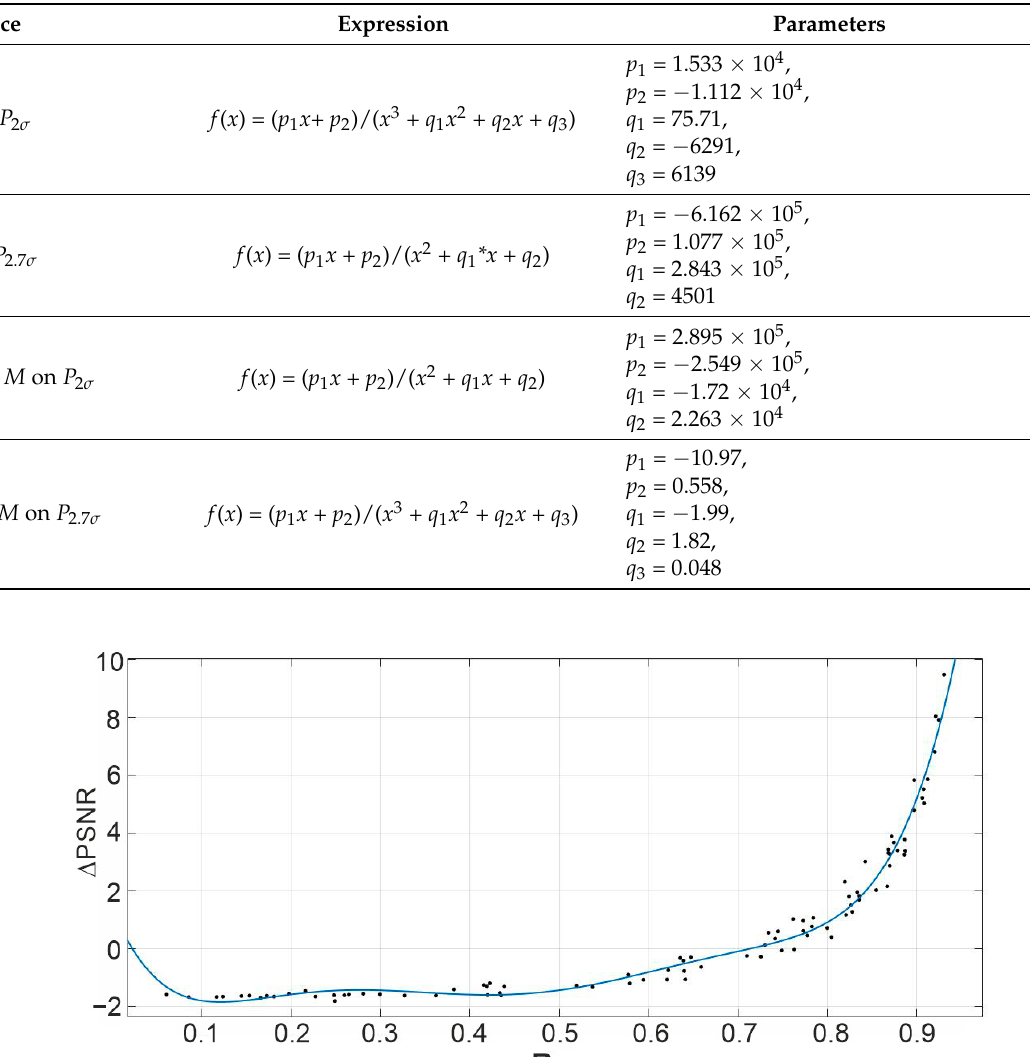
Figure 13. The scatter-plot ∆𝑃𝑆𝑁𝑅 − 𝐻𝑉𝑆 − 𝑀 vs. 𝑃 2𝜎 and the fitted curve (the weighted sum of two exponentials, RMSE is about 1.64 and the R 2 and AdjR 2 are about 0.87).